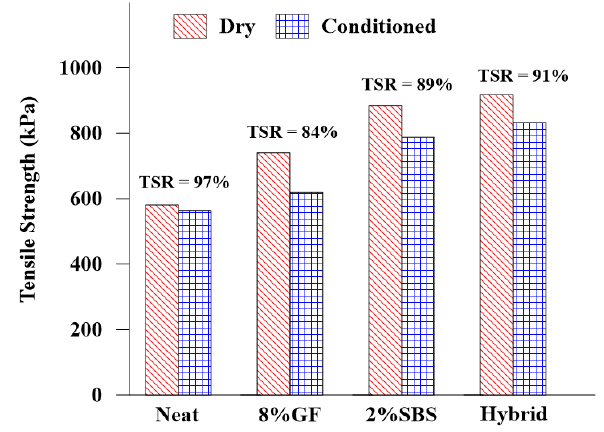
Figure 16. Moisture sensitivity